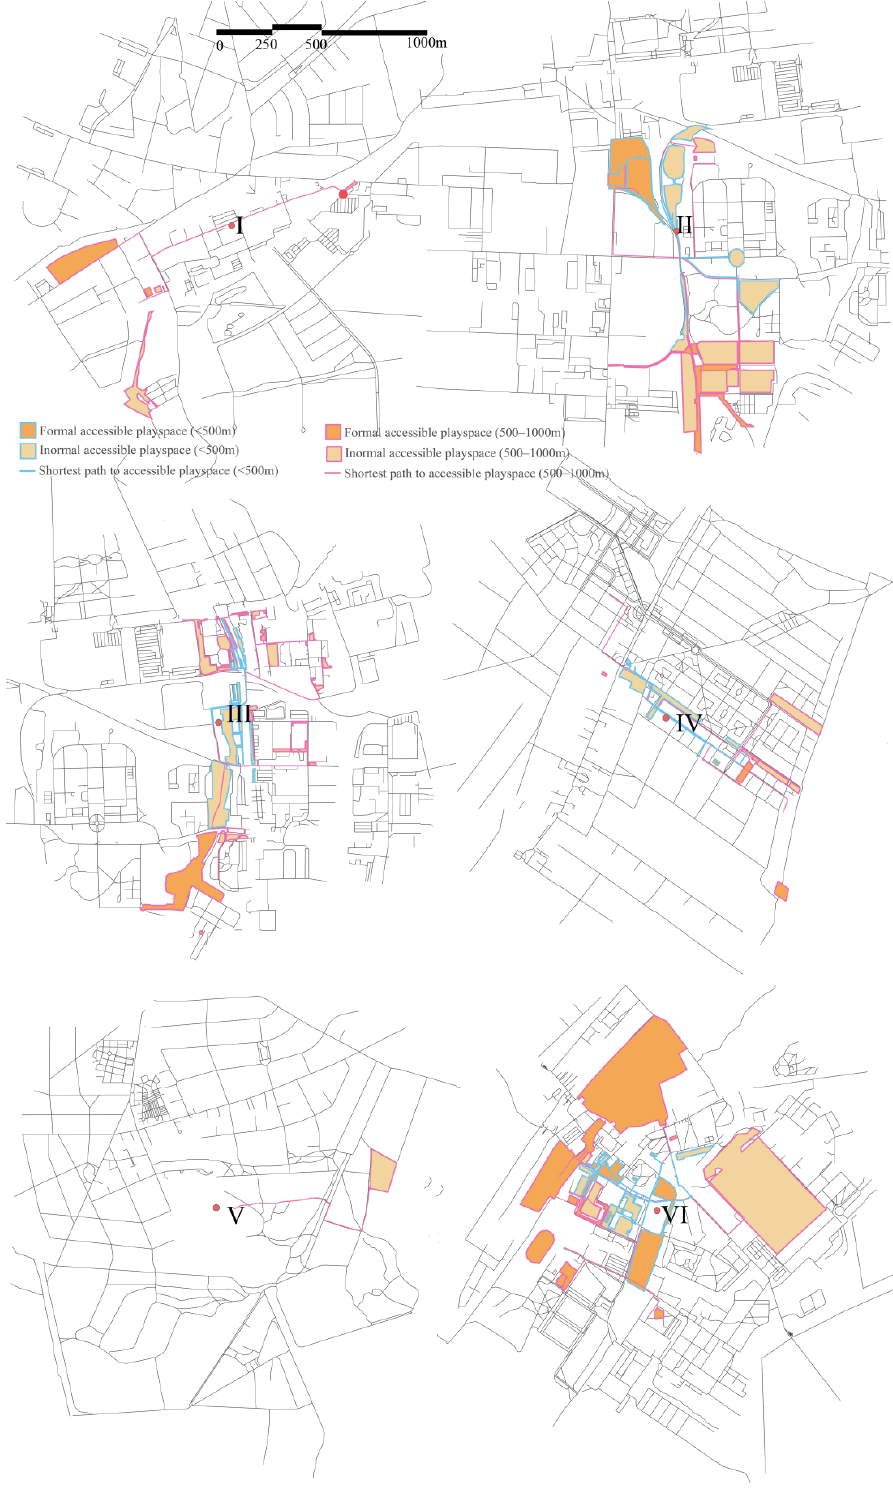
Figure 7. Accessible playspaces of six study sites.